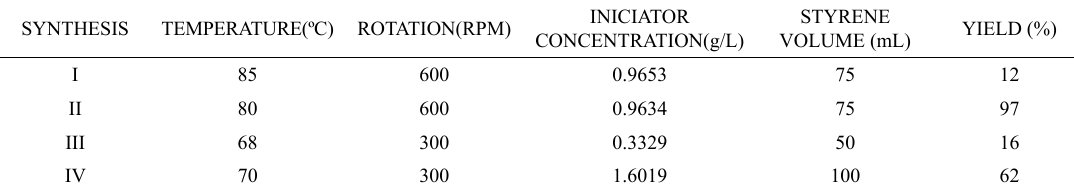
Table 1. Parameters for synthesis of latex beads.